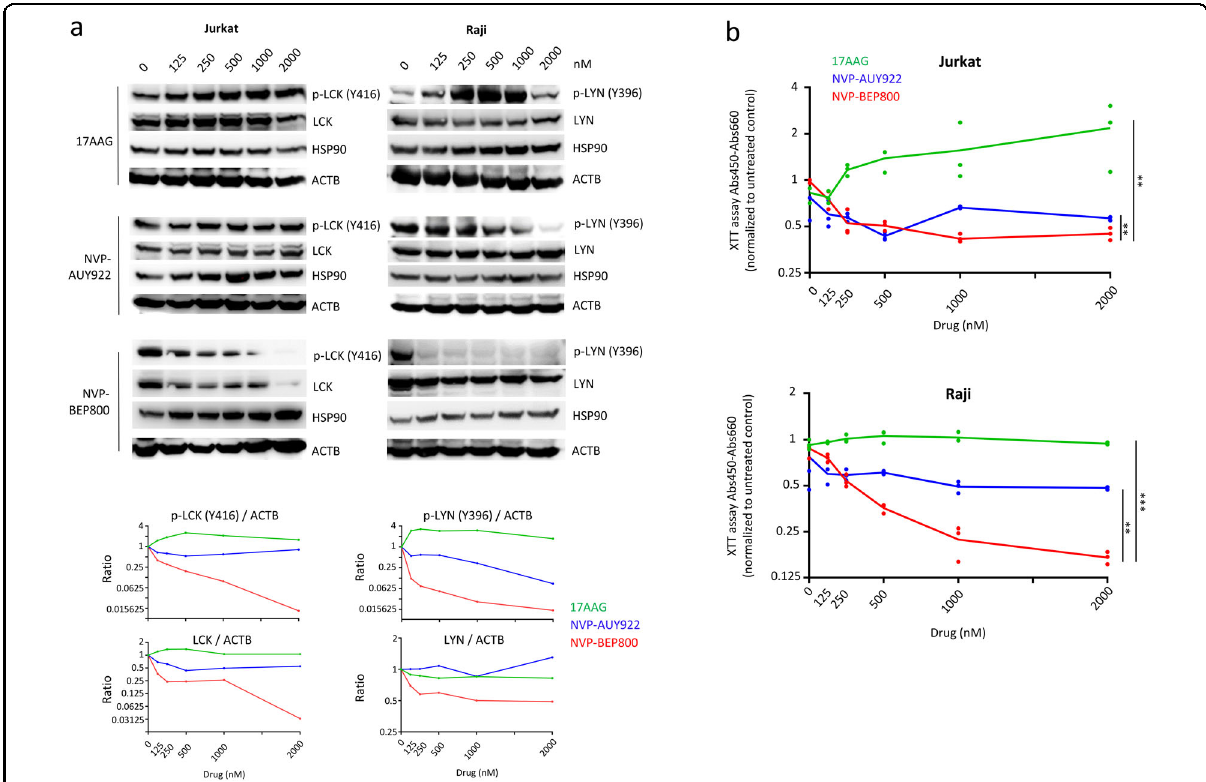
Fig. 1 Sensitivity of T- and B-lymphoid cell lines to NVP-AUY922, 17-AAG and NVP-BEP800. a Western blot shows that in Jurkat and Raji cells, levels of phosphorylated SRC and total SRC proteins are more affected after treatment with NVP-BEP800, compared to NVP-AUY922 or 17-AAG. Western blots after 18 h of treatment are shown on the top panel and quanti fi cations on the bottom panel. b XTT viability assay after 48 h of treatment shows that Jurkat and Raji cells are more sensitive to NVP-BEP800, compared to the other two compounds. Data are shown as mean; n = 3 biological replicates. P value measured by one-way Anova test with Tukey ’ s multiple comparison test; ** P < 0.01; *** P <